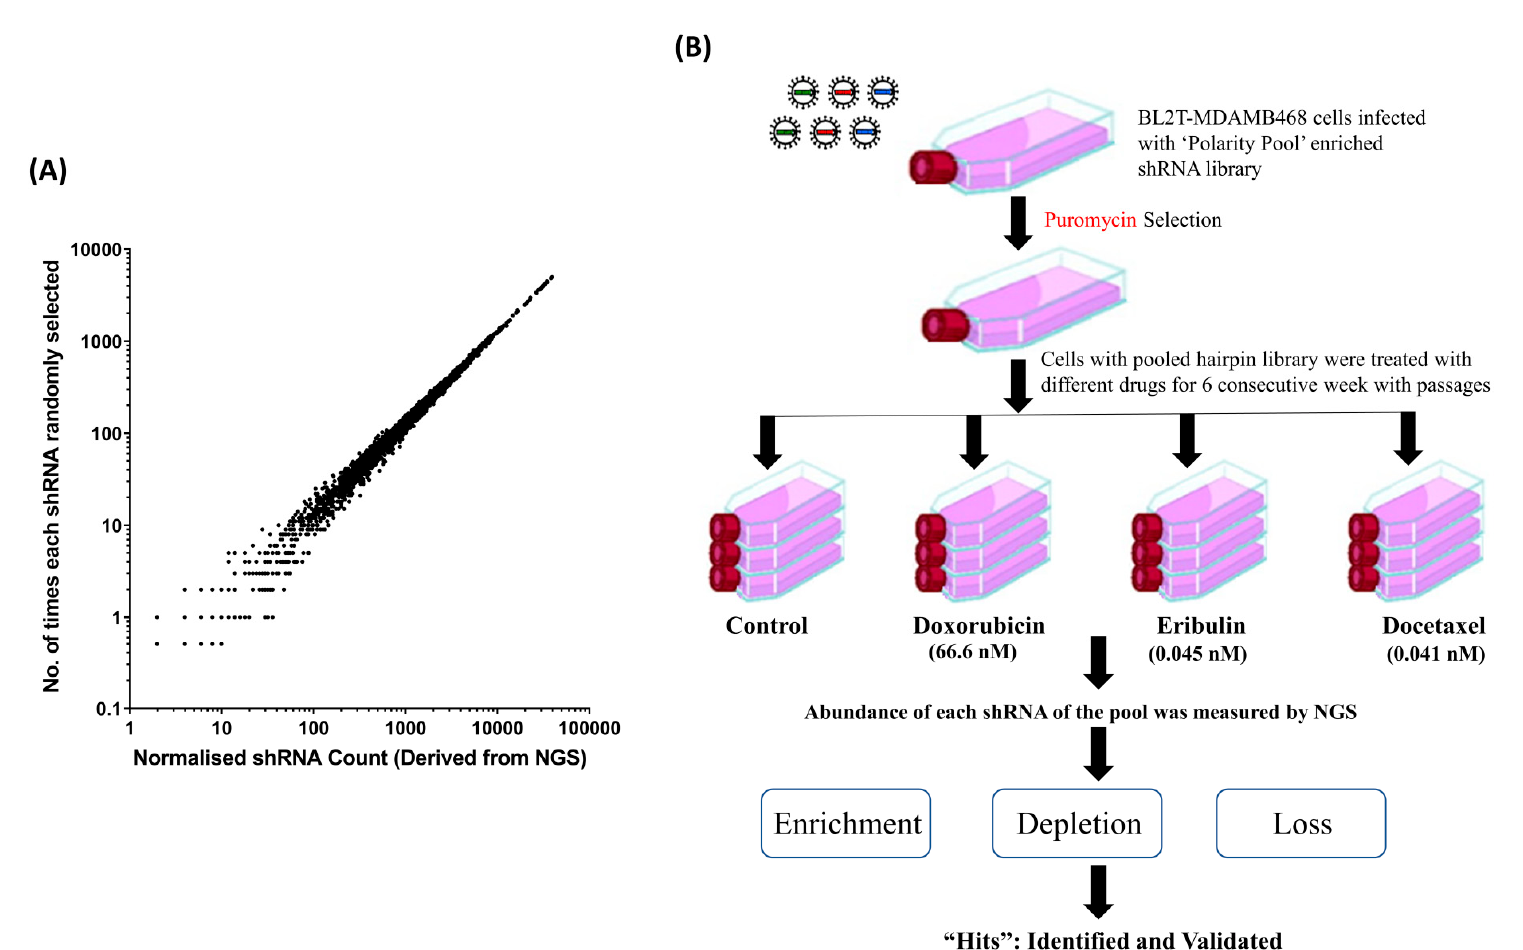
Figure 1. ( A ) Mathematical modelling to simulate the distribution of sampling error, in regard to previously obtained hairpin abundance in breast cancer cell line PMC42-LA induced with the same Polarity Pool-enriched library. ( B ) Workflow for the Polarity Pool-enriched short hairpin RNA (shRNA) library screen in breast cancer cell line MDA-MB-468 coupled with Ion Torrent sequencing to study genes involved in resistance against three chemotherapeutic drugs.